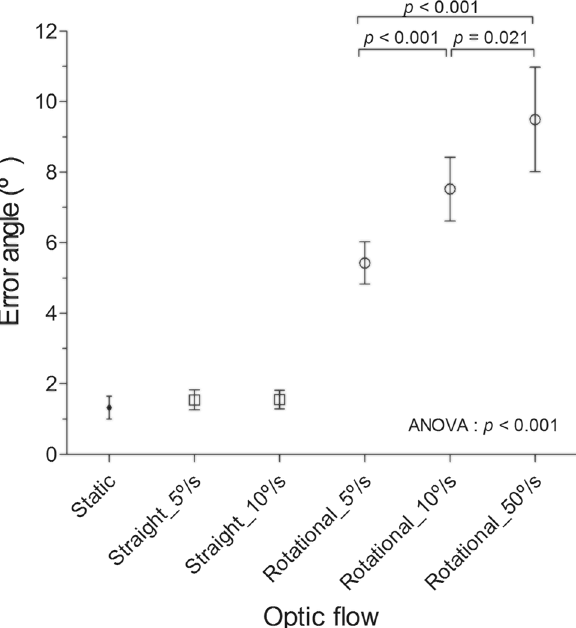
Figure 2. Error angles (°) for each directional optic flow (mean with 95% Confidence Intervals). Significantly higher error angles were confirmed in the rotational optic flow compared with the straight optic